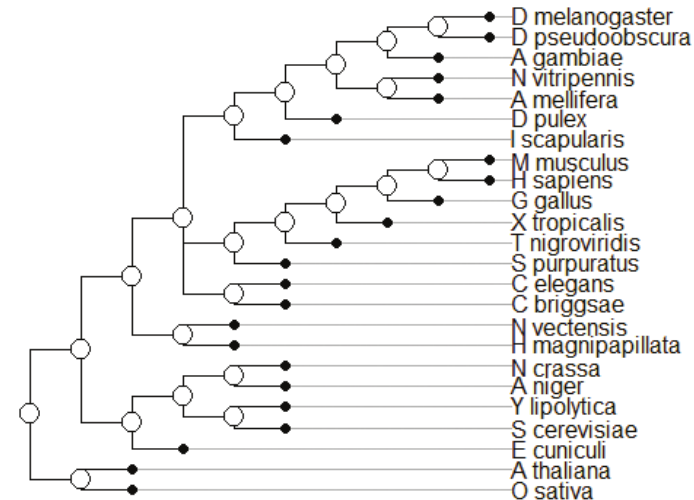
Figure 4. The phylotypic tree that we use to calculate the age index of Drosophila ’s genes. Each gene is assigned to one of the following six ages: Level-1: Common ancestor to Fungi, Plants and Eumetazoa. Level-2: Common ancestor to Fungi and Eumetazoa. Level-3: Common ancestor to all Eumetazoa. Level-4: Common ancestor to all Bilateria. Level-5: Common ancestor to all Arthropoda. Level-6: Common ancestor to all Dipteria. include gene deletion and duplication. Gene rewiring can cause